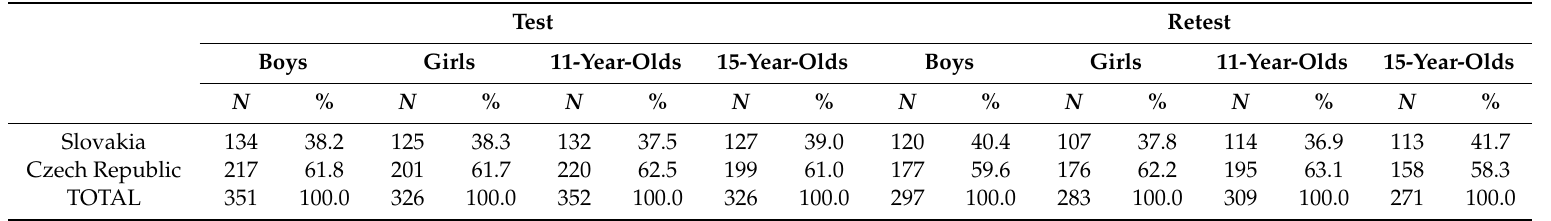
Table 1. Demographic characteristics of the sample (Slovakia and Czech Republic,